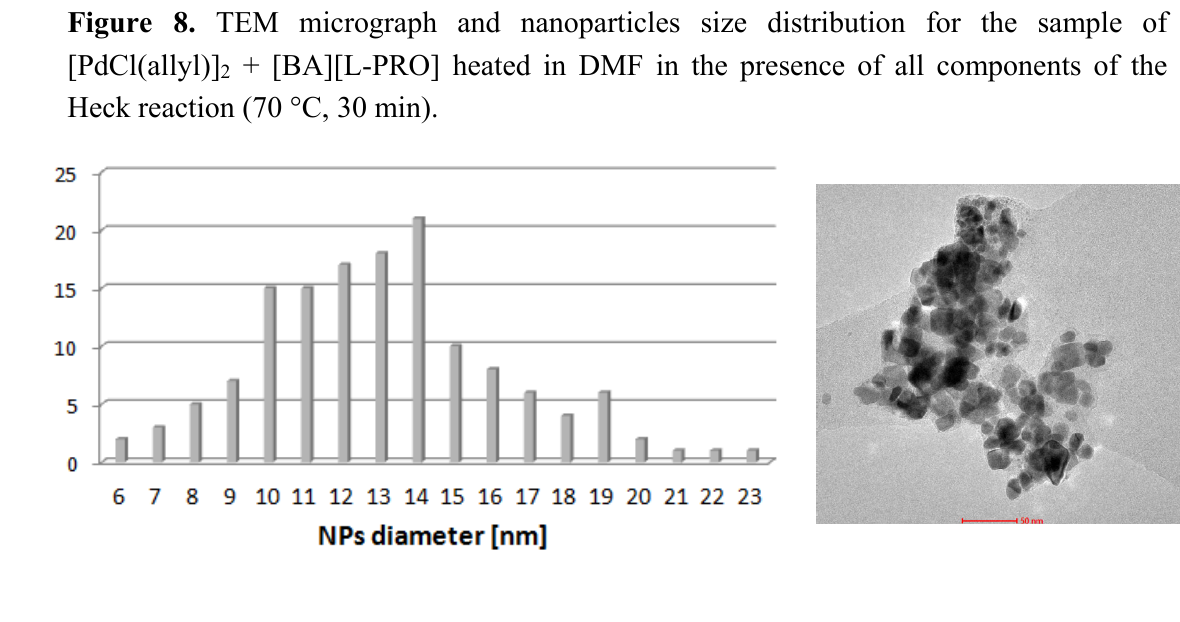
Figure 8. TEM micrograph and nanoparticles size distribution for the sample